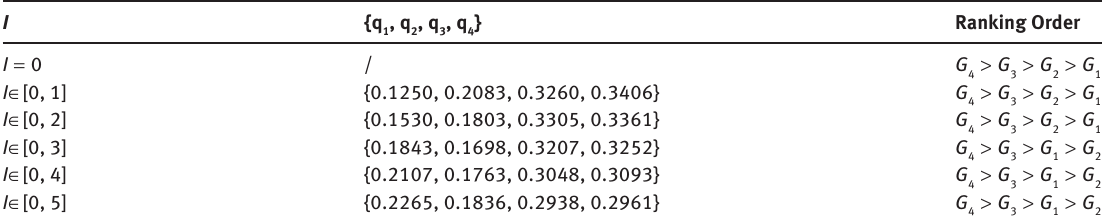
Table 2: Decision Results Choosing Different Indeterminate Ranges for